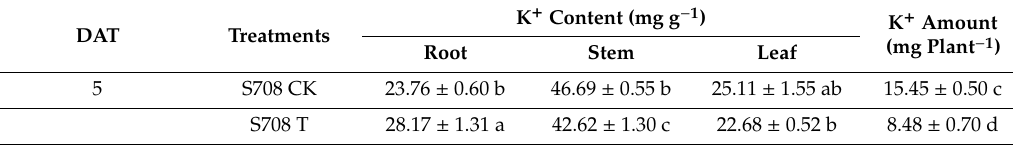
Table 2. K + content in roots, stems and leaves and K + amount in whole plants of the S708 and the T722 cultivar under normal (CK, 25 / 18 ◦ C) and sub-optimal temperature (T, 15 / 10 ◦ C) conditions at 5 and 10 DAT. Data are the means with standard deviation (n = 3 representing 3 biological replicates). Di ff erent letters on the same column indicate significant di ff erences attested by the Tukey’s HSD test ( p < 0.05). F -value from two-way ANOVA analysis of e ff ects of cultivar and temperature treatment on K + content in roots, stems and leaves and K + amount in whole plants.